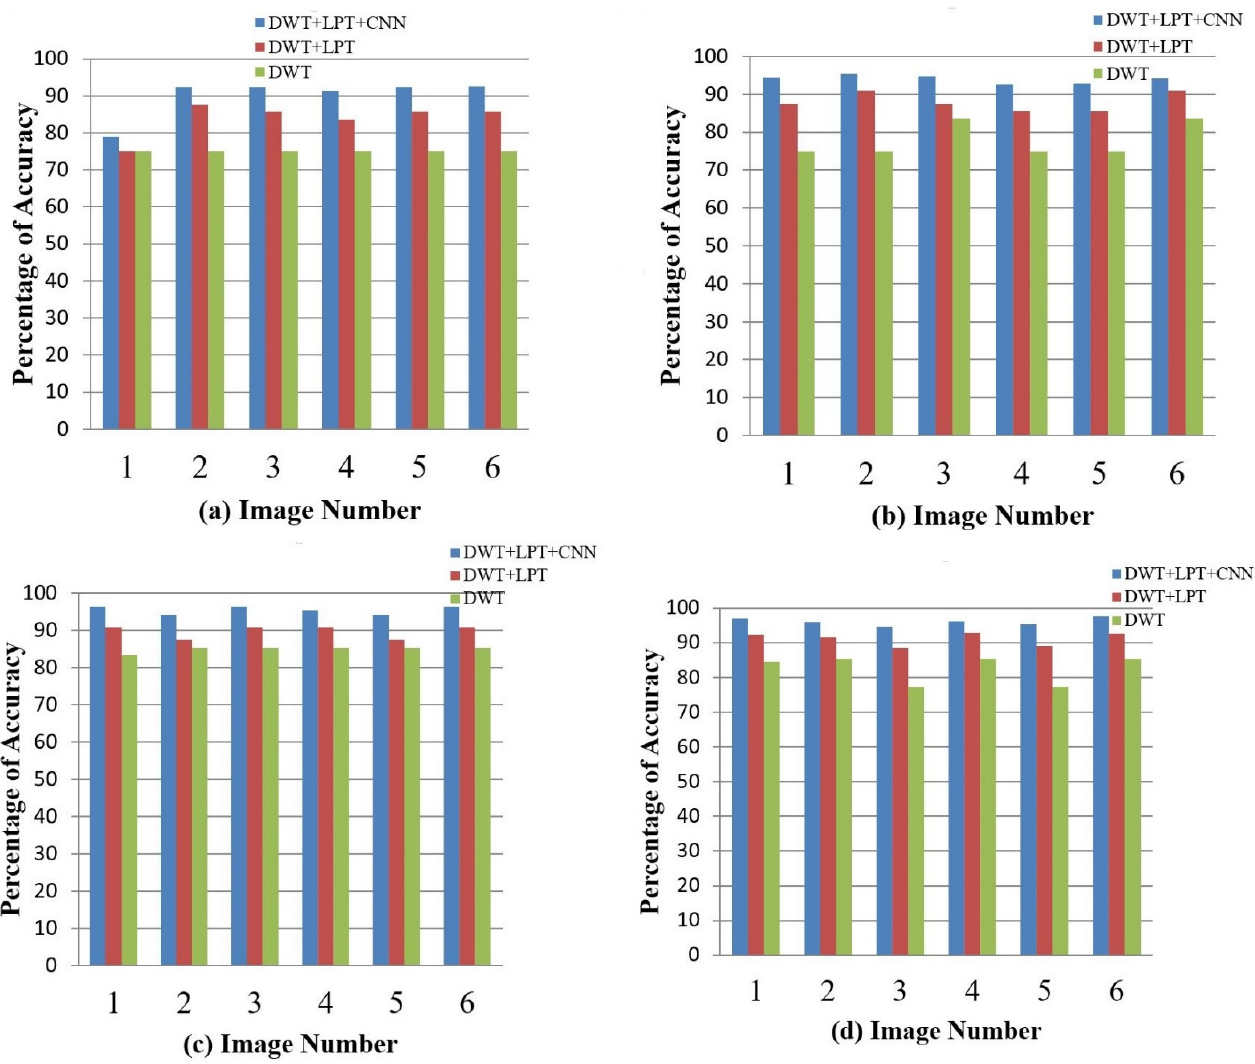
Figure 12. Average Accuracy for Tumor Detection of T-1 weighted images.